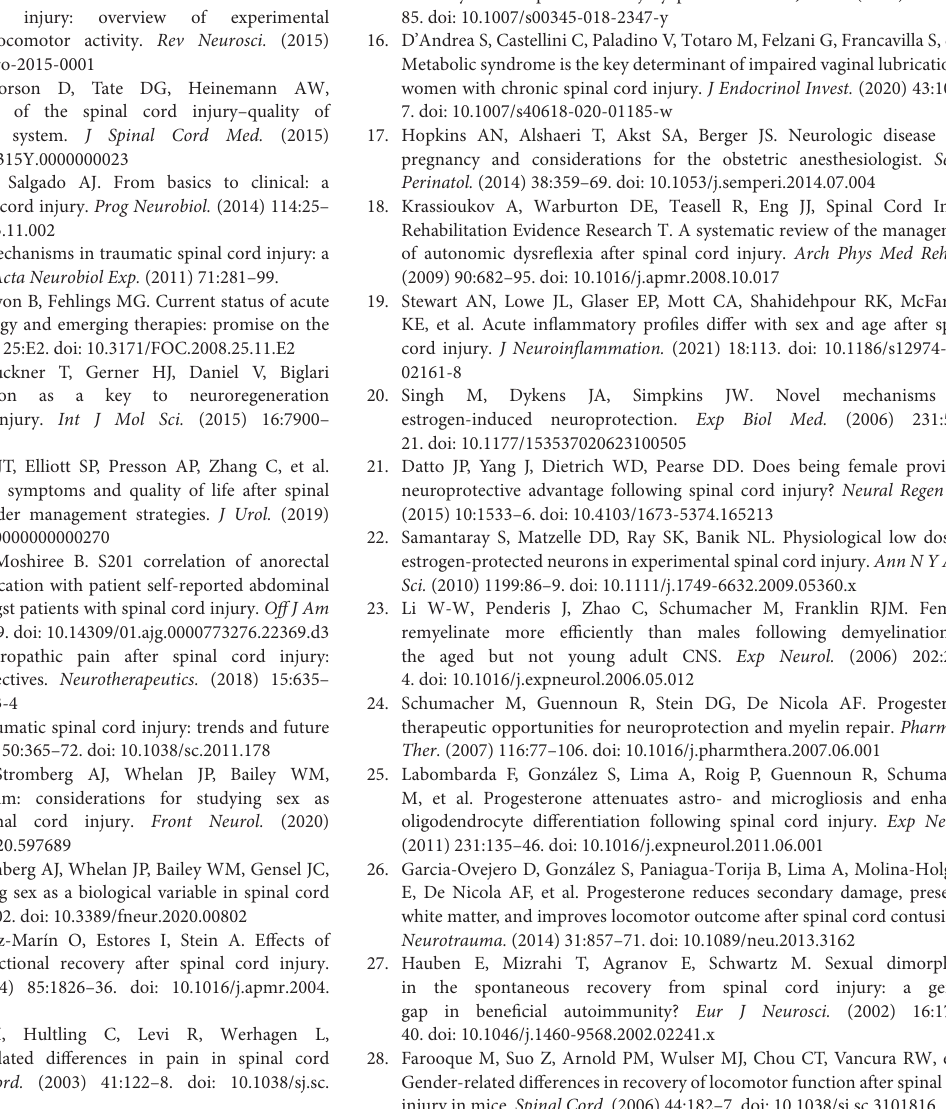
Supplementary Figure 3 | Representative images of rat footprints. (A,C,E) Footprints before SCI for 25M (A) , 35M (C) , and 35F (E) , respectively. (B, D, F) Footprints of the same animals [25M (B) , 35M (D) , and 35F (F) ] at 6-week post-SCI.